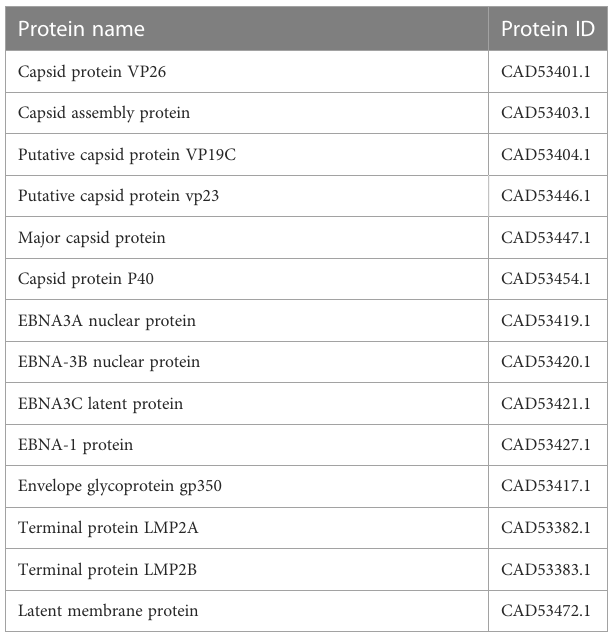
TABLE 1 Selected proteins from an assembly of Human gamma herpes